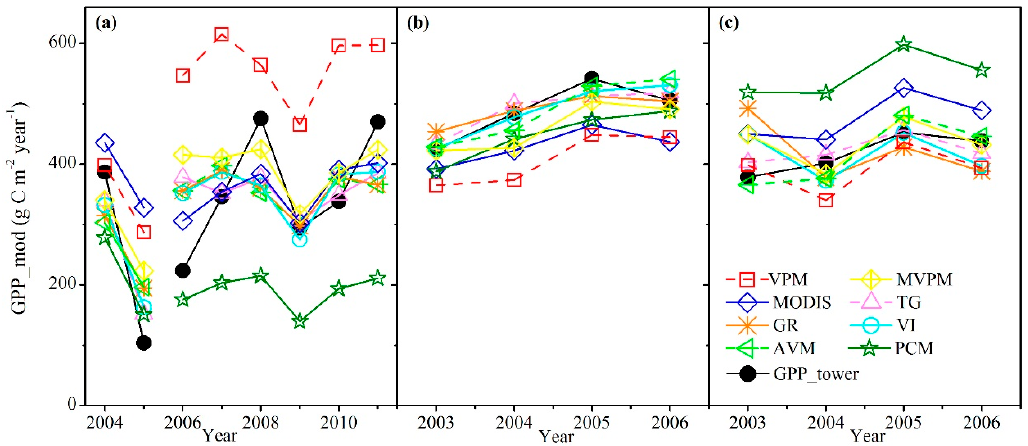
Figure 7. Comparisons of the modeled annual GPP with observations in the ( a ) temperate steppe, ( b ) alpine shrub meadow, and ( c ) alpine swamp meadow.